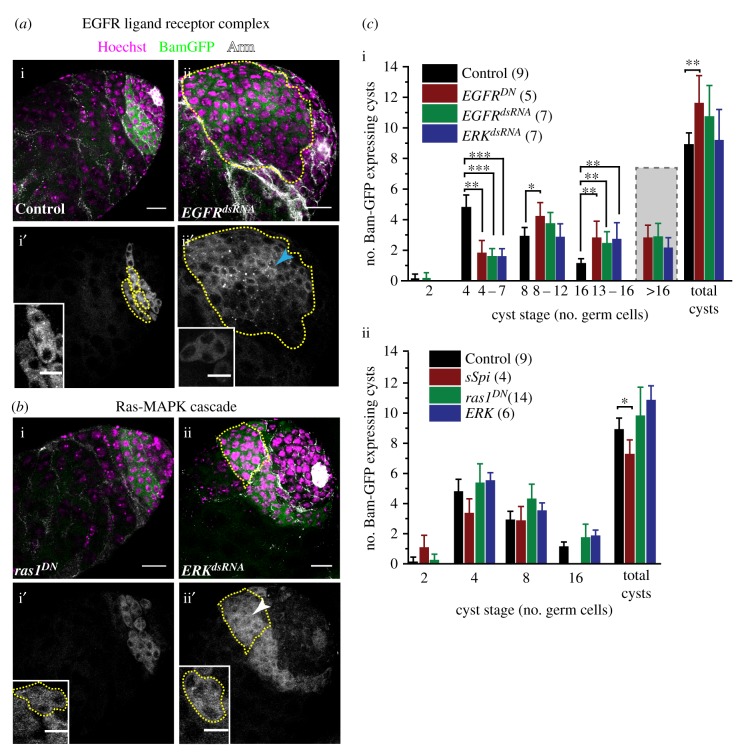
Loss of EGFR signalling in SCCs deregulates the termination of bam expression in the germline cells. (a,b) Testes from tjGal4 bamp-BamGFP/+; UAS-His2A-RFP/+(Control) (a-i), tjGal4 bamp-BamGFP/+; UAS-His2A-RFP/UAS-EGFRdsRNA (EGFRdsRNA) (a-ii), UAS-ras85DDN/Y; tjGal4 bamp-BamGFP/+; UAS-His2A-RFP/+ (ras1DN) (b-i), and tjGal4 bamp-BamGFP/+; UAS-His2A-RFP/UAS-ERKdsRNA (ERKdsRNA) (b-ii) were stained with anti-Arm (white) marking the cyst boundary and Hoechst 33342 (magenta). BamGFP (green) fluorescence marked the bam-expressing stages. (a-i′,ii′, b-i′,ii′) Grey LUT of BamGFP fluorescence in the testes and magnified views of 4-cell cysts (insets) highlight the Bam levels in individual germ cells within cysts in different genetic backgrounds. (c) Histograms depict mean (±s.d.) bam-expressing cysts in different genotypic backgrounds. In the EGFR and ERK backgrounds, often the cyst boundaries were not clear. Therefore, they are enumerated in a range bound manner. All scale bars, error bars and statistical significance values are applied according to the description in figure 1. Inset scale bars measure 10 µm.